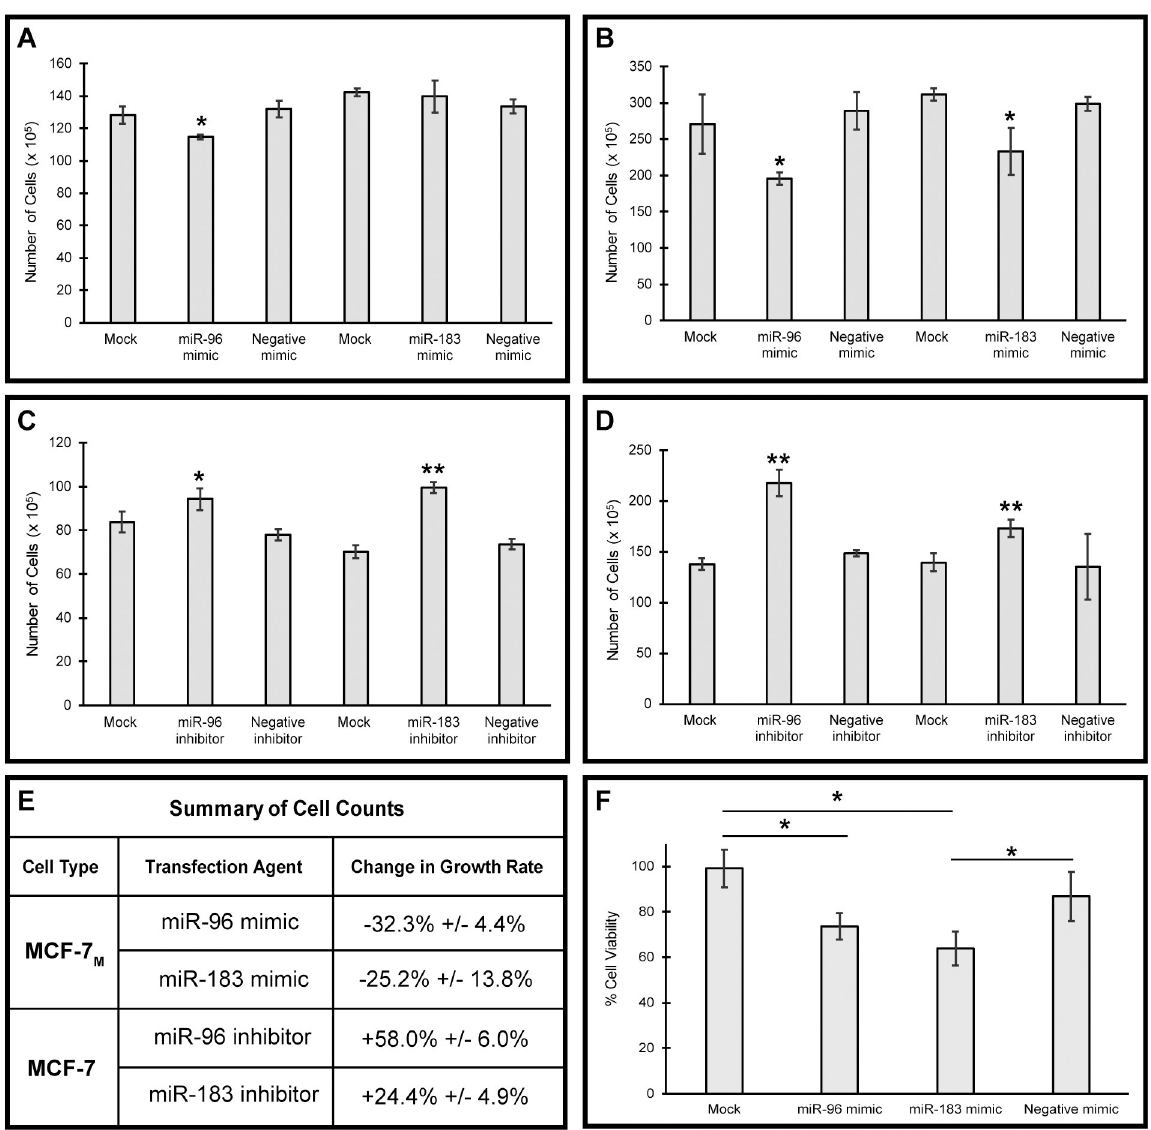
Fig 3. MicroRNAs miR-96 and miR-183 regulate cell viability. 50nM of mirVana ™ miRNA mimics for miR-96, miR-183, or Negative Control #1 were transfected into MCF-7 M cells (A, B) and 50nM of mirVana ™ miRNA inhibitors for miR-96, miR-183, or Negative Control #1 were transfected into MCF-7 cells (C, D). Cell counts were determined by staining with 0.4% trypan blue solution after 24 hours (A, C) or 48 hours (B, D), and averages and standard deviations of triplicate counts over three independent experiments are reported. (E) Calculated average percent change in viable cells for mock treatment vs. miRNA mimic or inhibitor treatment 48 hours post-transfection ± standard deviation. (F) A MTT Assay was performed to obtain an additional quantitative measure of cell viability in MCF-7 M cells. Statistical significance was determined using a one-way ANOVA followed by a Tukey-Kramer post-hoc test ( � p < .05; �� p <